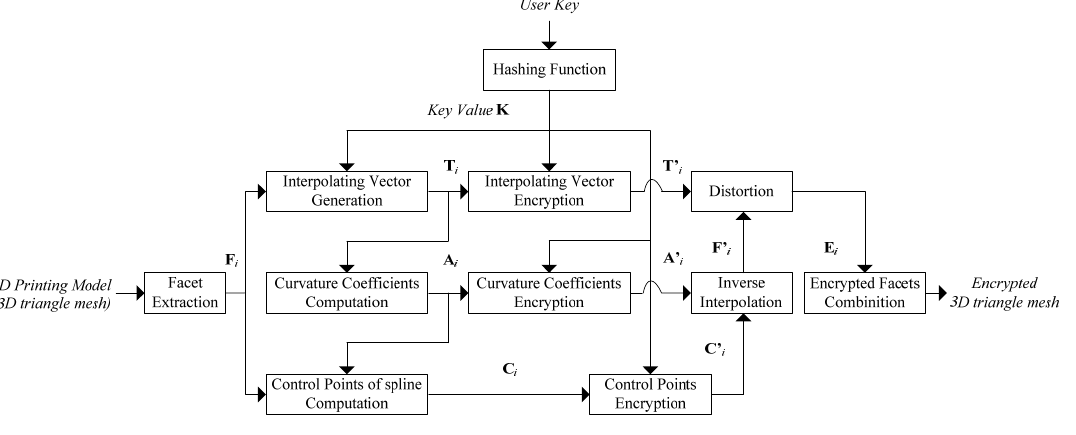
Figure 2. The proposed algorithm.